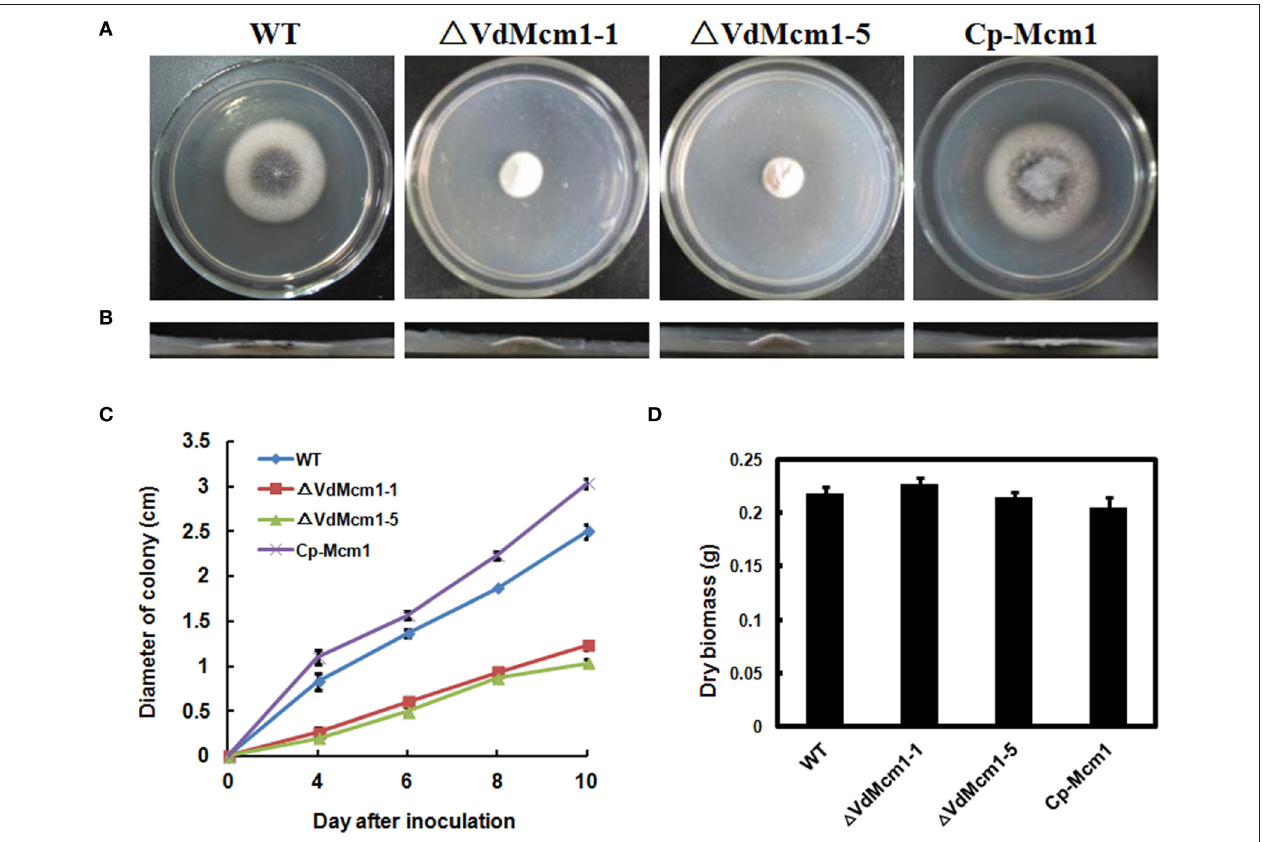
FIGURE 2 | VdMcm1 disruption results in reduced fungal growth. (A) Colony morphology of wild-type strain, VdMcm1 deletion mutants ( 1 VdMcm1-1, 1 VdMcm1-5 ), and the complemented strain after 10 days of growth on PDA plates. (B) Vertical dissection of the colonies on PDA plates. (C) Radial growth rate of the strains on PDA plates. (D) Relative dry biomass of the indicated strains grown in liquid CM for 9 days at 25 ◦ C. The error bars represent standard deviations. The experiments were performed in